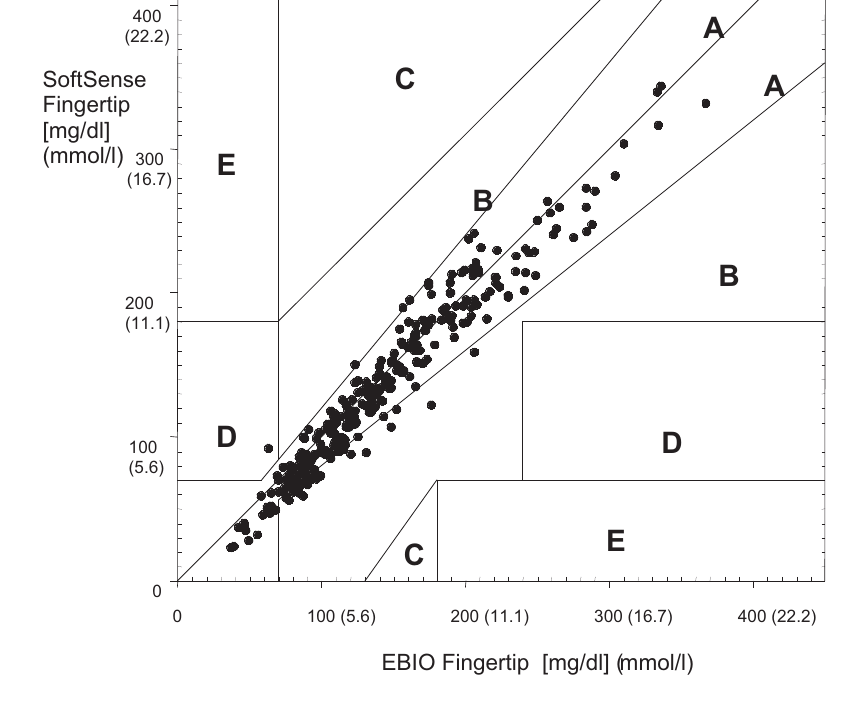
Bland-Altman- Analysis of the Soft-Sense mea- surements at the arm compared with the reference method. The black lines frame the area of acceptance as given by the new ISO/DIS 15197 guidelines.